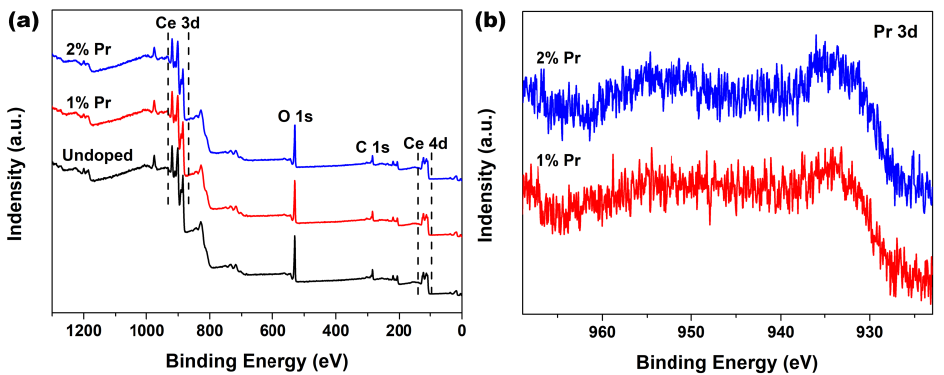
Figure 2. ( a ) XPS spectra of Undoped, 1% and 2% Pr-doped CeO 2 and ( b ) the corresponding XPS regions of Pr3d of 1% and 2% Pr-doped CeO 2 .